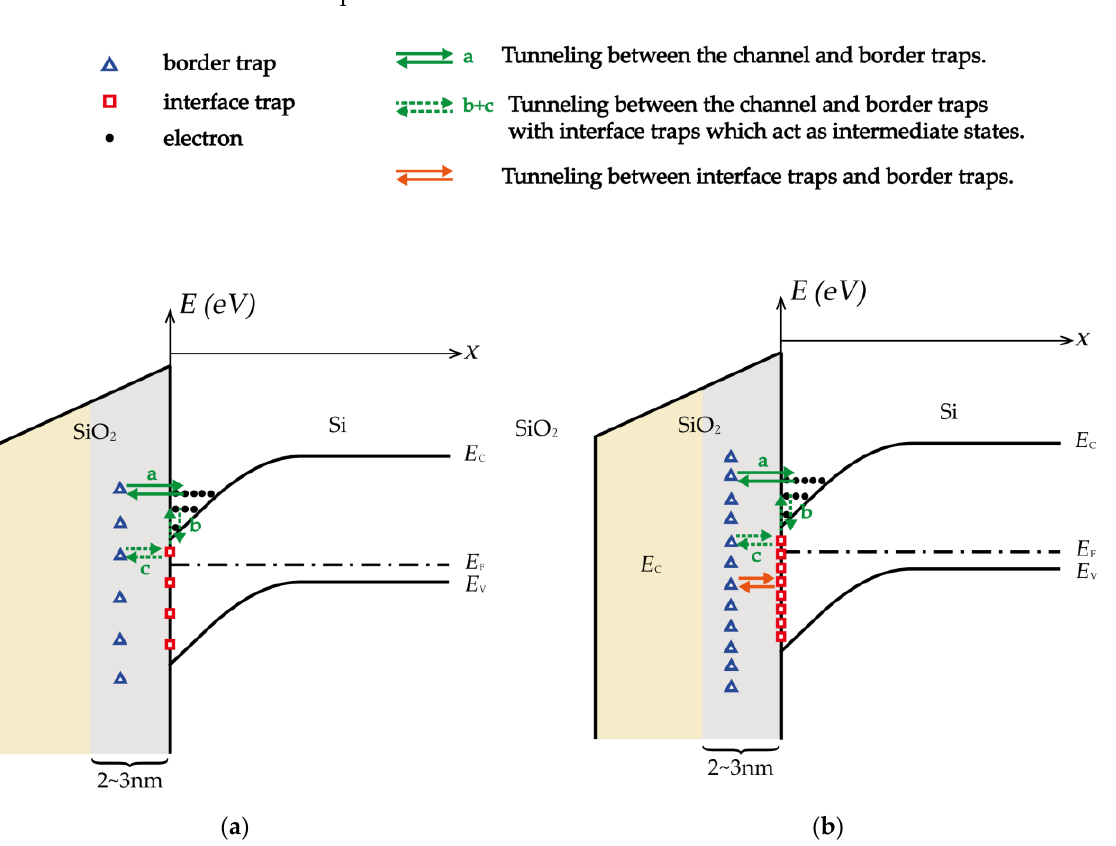
Figure 8. The physical processes of the origin of low-frequency noise in NMOSFETs under ( a ) pre- irradiation/lower-dose irradiation and ( b ) higher-dose irradiation in the energy band diagram.